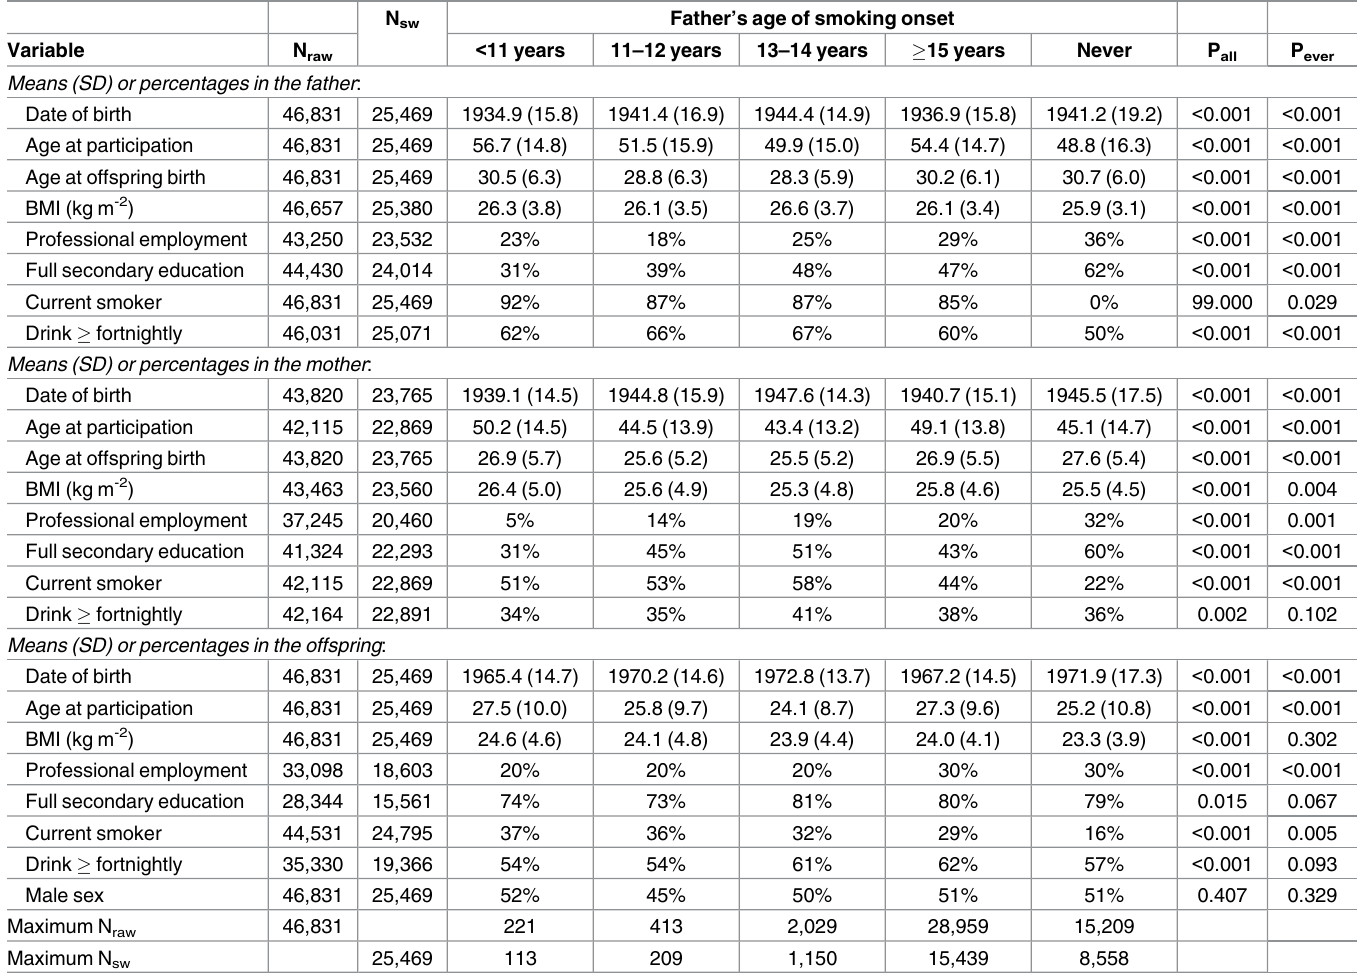
Table 1. Characteristics of fathers, mothers and offspring according to the father’s age of smoking